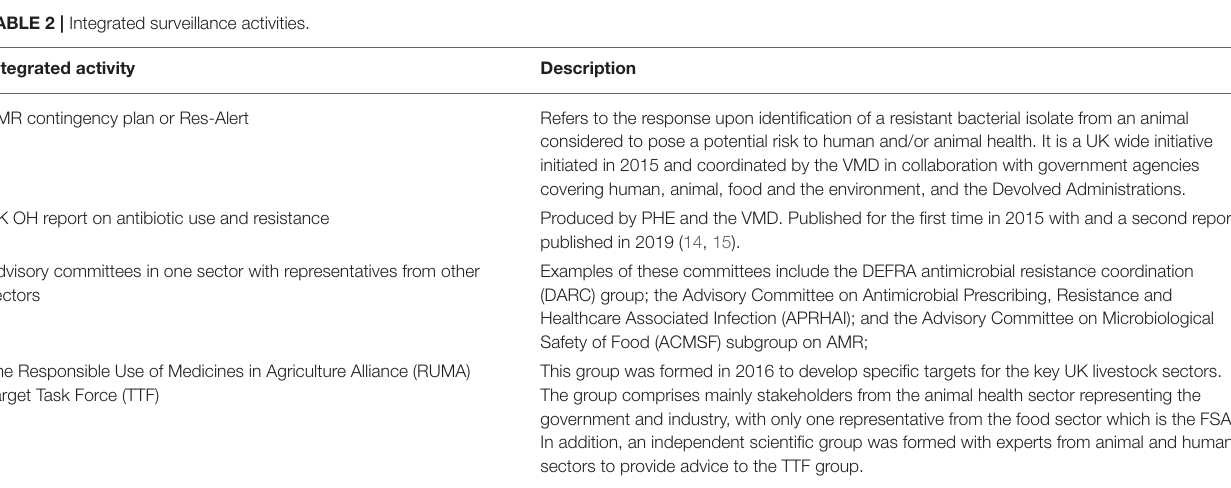
TABLE 2 | Integrated surveillance